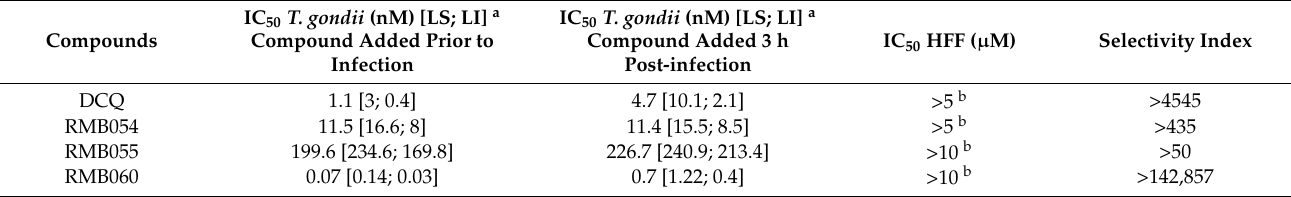
Table 1. In vitro activities against T. gondii and cytotoxicity against HFF. Compounds